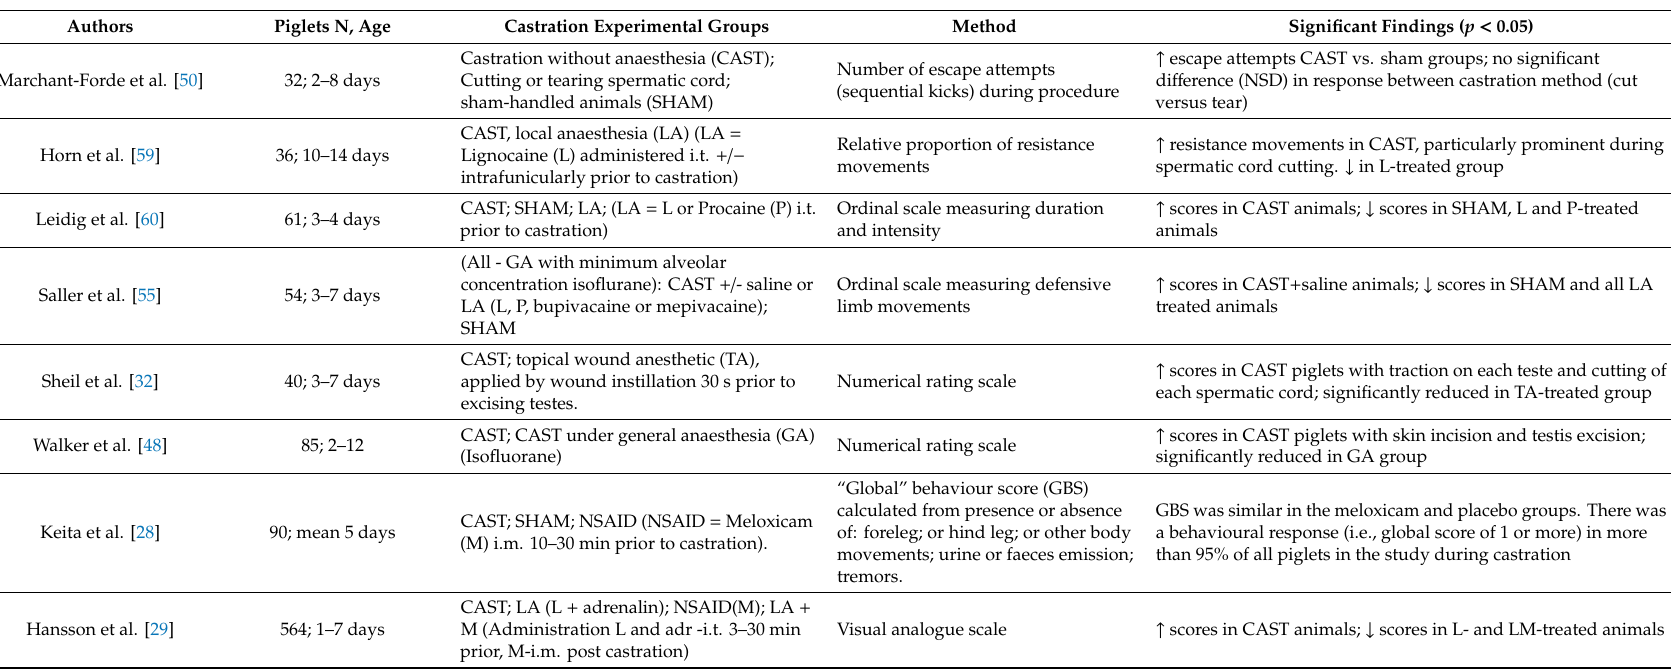
Table 2. Summary of studies measuring motor response movements during